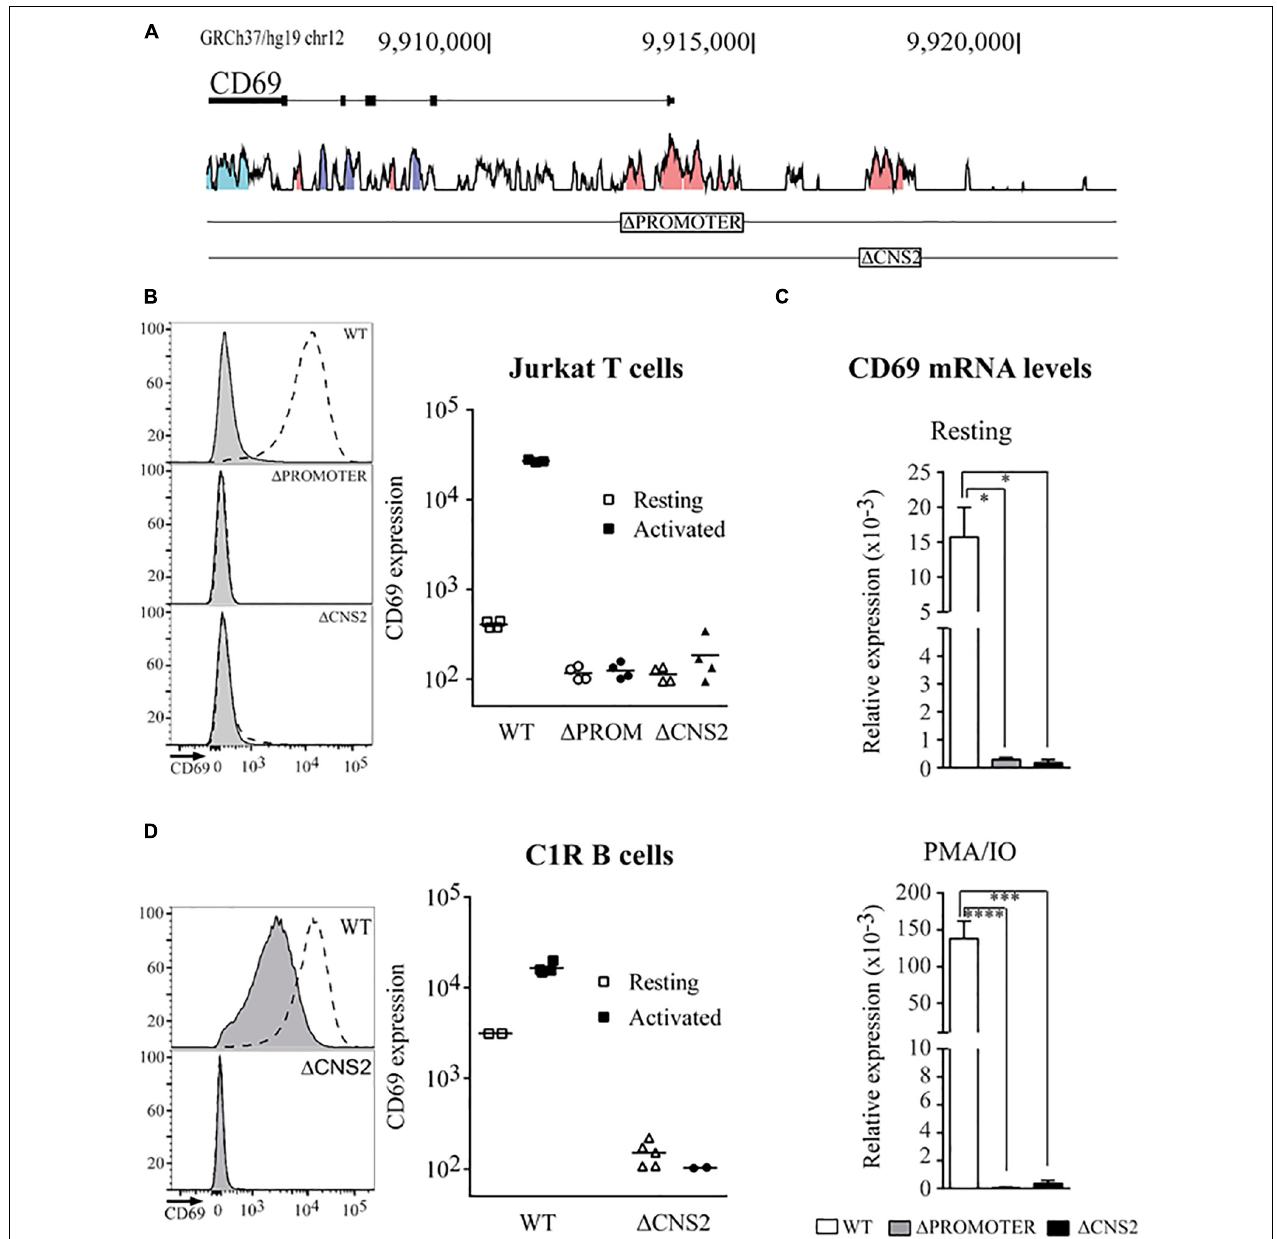
FIGURE 1 | Deletion of the CNS2 regulatory element impairs CD69 mRNA and protein expression. (A) Vista browser tracks (http://pipeline.lbl.gov/cgi-bin/gateway2) showing conservation between the human and mouse CD69 gene locus (GRCh37/hg19 assembly, chr12:9,905,077-9,920,582). Blue = untraslated regions, Purple = exons, Pink = conserved non-coding regions. Boxes indicate the deleted regions. (B,D) Flow cytometry analysis of CD69 surface expression in Jurkat T Cells (B) or C1R B cells (D) Left. Representative histograms of the expression profiles for Promoter or CNS2 deletion in cells stimulated (dotted line) or not stimulated (gray line) with PMA/IO for 24 h. Right. Mean fluorescence intensity (MFI) of different wild-type (squares), (cid:49) Promoter (circles) or (cid:49) CNS2 (triangles) clones, either unstimulated (empty) or stimulated (filled). (C) . CD69 mRNA levels in basal conditions and after 3 h PMA/IO stimulation in WT, (cid:49) Promoter, and (cid:49) CNS2 conditions. Data represent the mean ± SEM of three experiments using three different clones. ns: non-significant, * p < 0.05, ** p < 0.01, *** p < 0.001, **** p < 0.0001.